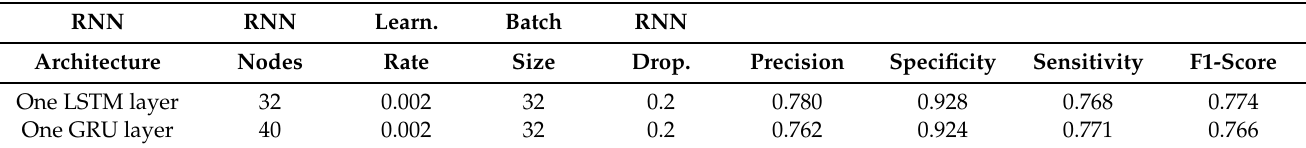
Table 9. Best results obtained after grid search